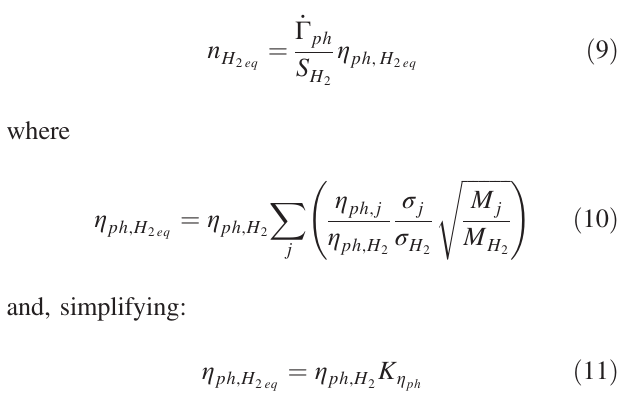
FIG. 2. Comparison of the FCC-hh SR spectrum vs the LHC ’ s, highlighting the critical energy values. Figure taken from [7].